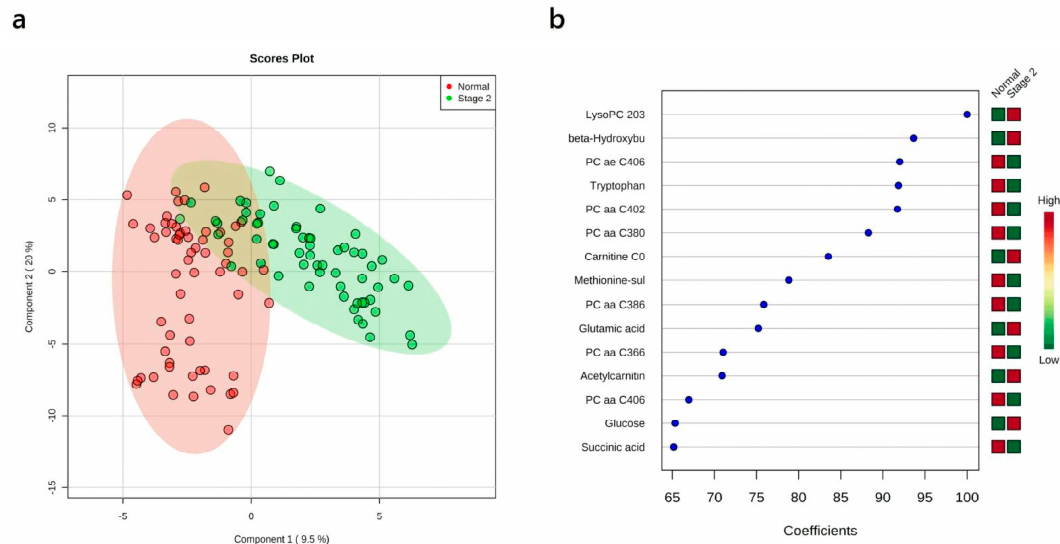
Figure 3. PLS-DA results showing the comparison between plasma metabolite data acquired for healthy controls vs. stage II NSCLC patients. ( a ) 2-D PLS-DA scores plots; ( b ) variable importance in projection plot. The most discriminating metabolites are shown in descending order of their coefficient scores. The color boxes indicate whether metabolite concentration is increased (red) or decreased (green) in controls vs. cases.